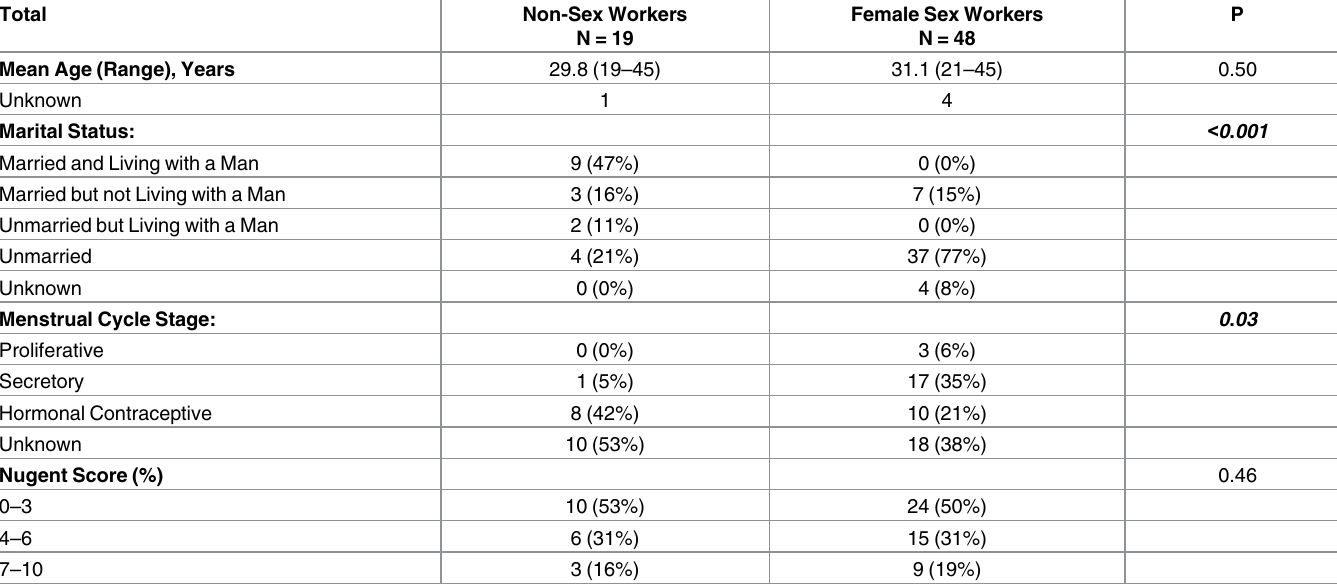
Table 1. Characteristics of non-sex workers and female sex